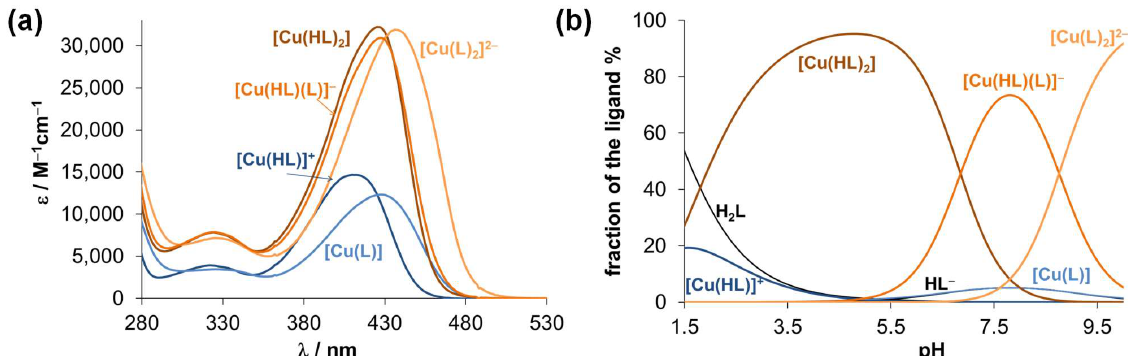
Figure 4. ( a ) Calculated molar UV-vis absorption spectra of the Cu(II) complexes with HQNO 2 -L-Pro. ( b ) Concentration distribution curves computed for the Cu(II)-HQNO 2 -L-Pro (1:2) system. H 2 L is the neutral form of the ligand (COO − , N Pro H + , N quinoline , OH). { c ligand = 40 μM; I = 0.10 M KCl; t = 25.0 °C}.